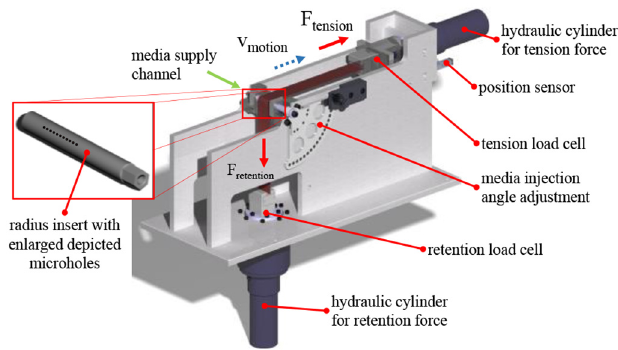
Fig. 15. Design of the testing rig for de fl ected strip drawing experiments